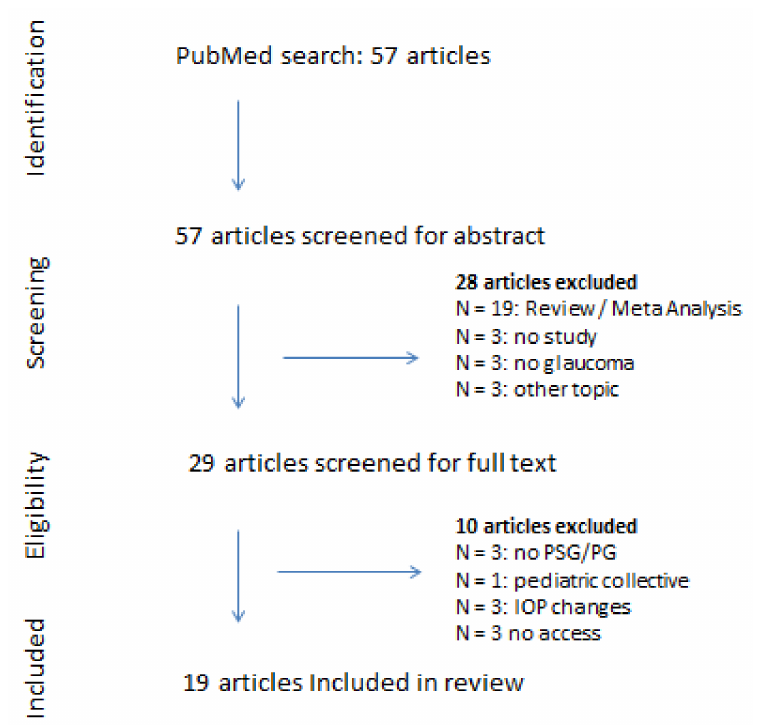
Figure 1. Literature selection process.